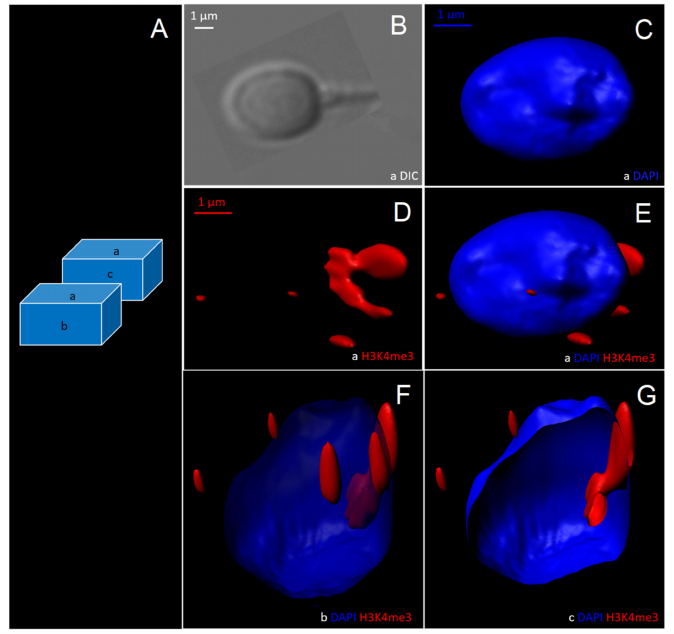
Figure 7. Three-dimensional reconstruction by optical sectional microscopy and deconvolution of a morphometrically normal spermatozoon without vacuole, tagged for H3K4me3. ( A ) Schematic of the upper plane (a), frontal plane (b), and a cross-section (c) of the spermatozoon. ( B ) The spermatozoon visualized with differential interference contrast (DIC). Three-dimensional reconstructed images of the spermatozoon with ( C ) DAPI labelling, ( D ) H3K4me3 labelling, and ( E – G ) DAPI/H3K4me3